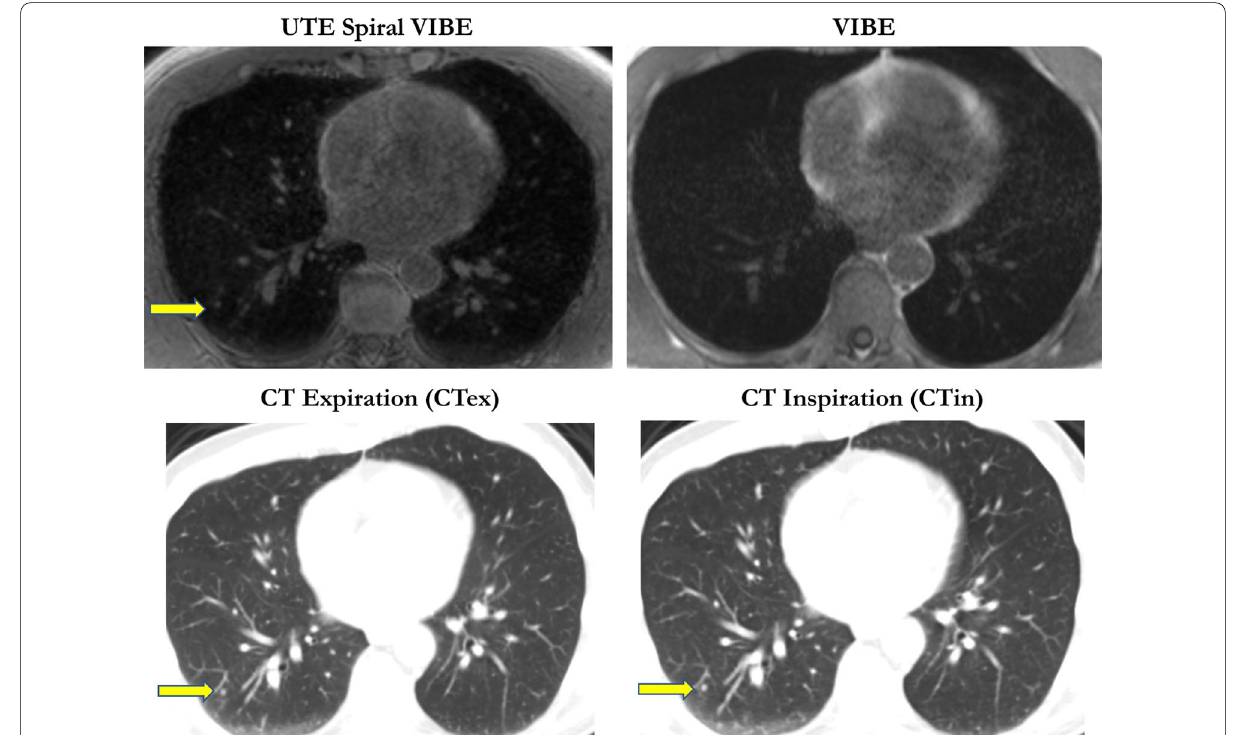
Fig. 2 Pulmonary nodule in the right lower lobe was detected in UTE Spiral VIBE and both CT examinations (arrow; 3 mm). However, the lesion was not visible in VIBE in a patient with rectal